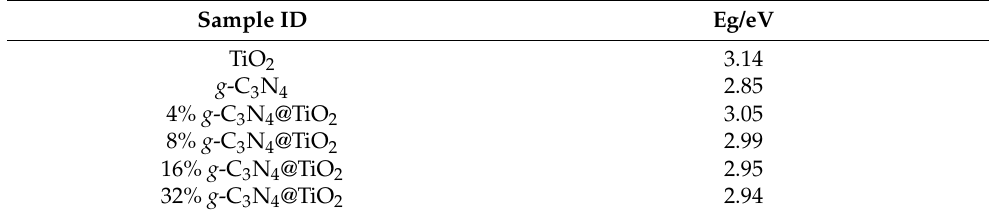
Table 1. Band gap energies (Eg) of prepared materials.